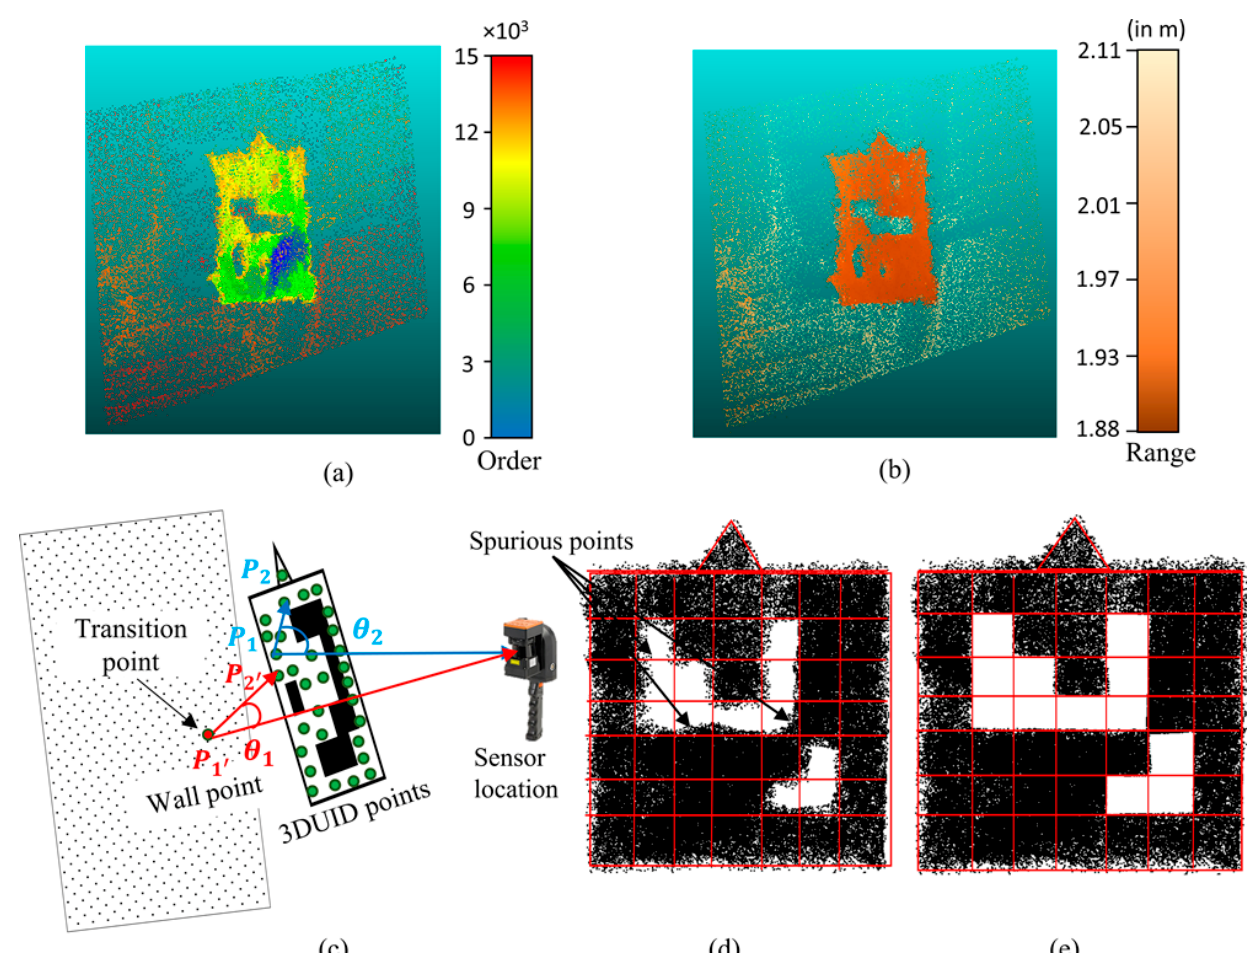
Figure 6. ( a ) An ordered point cloud with point transitions shown using a colour scale, ( b ) point cloud coloured with respect to range showing the variability of 3DUID points with respect to surrounding points, ( c ) concept of point angle showing the angle of point transition with respect to the nearest sensor location. Transition point shown in red denotes that after this point transition from wall to 3DUID occurred. ( d ) Some of the spurious points encountered in the void region of 3DUID due to sensor range inaccuracy, and ( e ) point cloud of 3DUID after removing spurious points using threshold number of points in a grid.